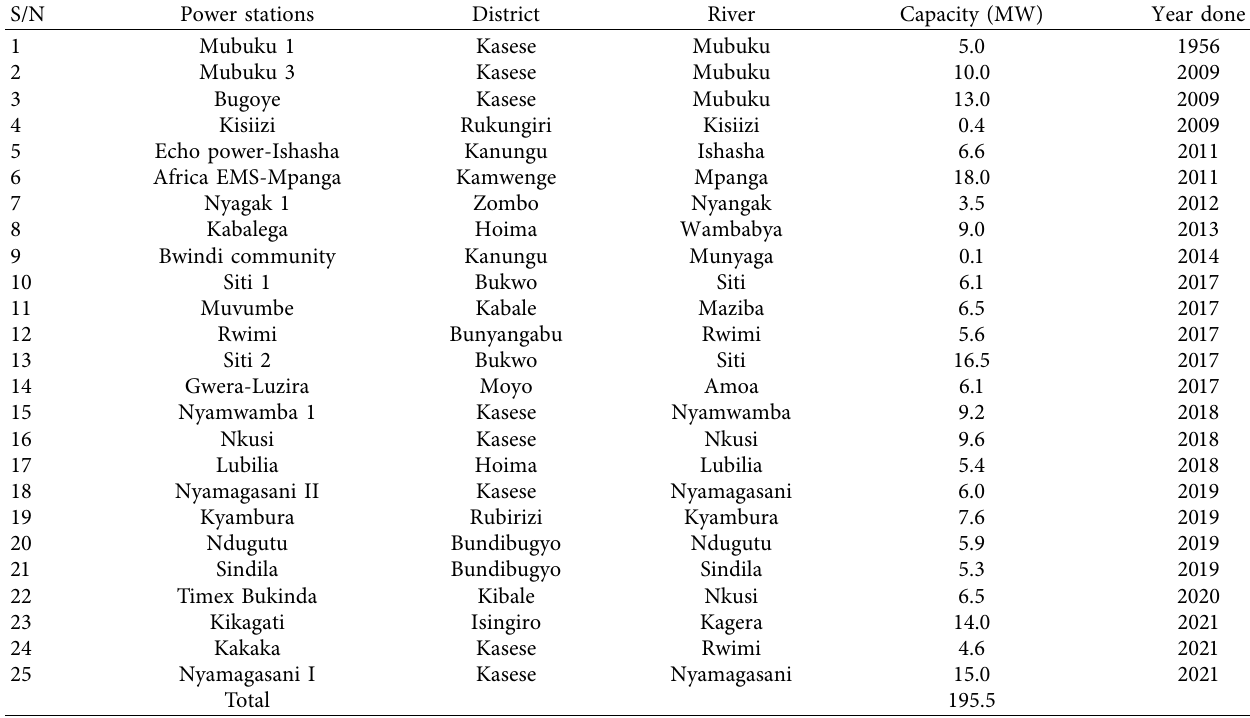
Table 4: Operational small hydropower